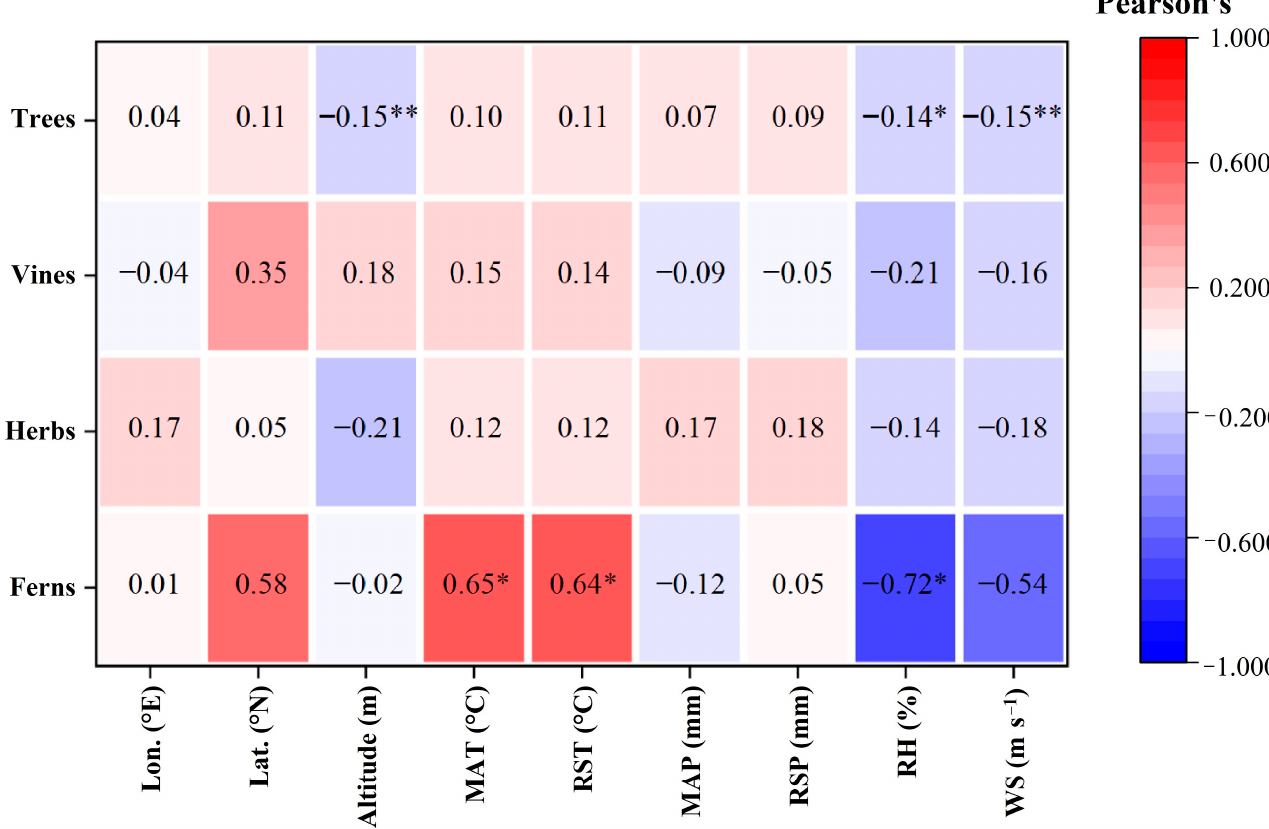
Figure 5. Pearson correlation coefficient of leaf intrinsic WUE in different plant functional types. * and ** indicate significant correlations at p < 0.05 and p < 0.01, respectively. The color in the figure represents the correlation coefficient, with red indicating a positive correlation and blue indicating a negative correlation. Lon., longitude; Lat., latitude; MAT, mean annual temperature; RST, rainy season temperature; MAP, mean annual precipitation; RSP, rainy season precipitation; RH, relative humidity; WS, wind speed.